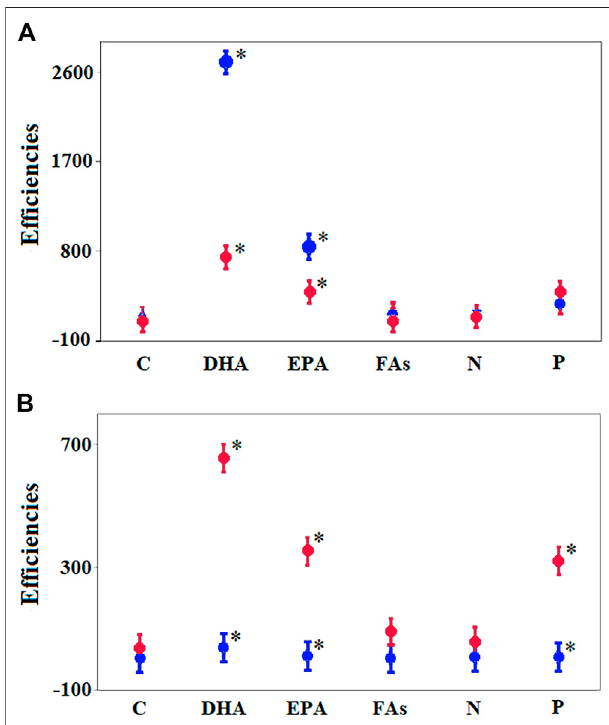
FIGURE 6 | Comparison of the transfer ef fi ciencies of essential substances on day 30 between C-2017 (blue circles) and ZM-2017 (red circles) (A) and between C-2018 (blue circles) and F-2018 (red circles) (B) using two-factor GLM ANOVA (random factor — treatments; fi xed factor — macrobiota). Signi fi cant differences were determined using Fisher ’ s LSD post hoc test (2017: F (cid:2) 41.7, p << 0.001; 2018: F (cid:2) 20.7, p << 0.011). Signi fi cant differences were found for DHA (2017: F (cid:2) 63.6, p (cid:2) 0.001; 2018: F (cid:2) 25.4, p << 0.007), EPA (2017: F (cid:2) 7.1, p (cid:2) 0.05; 2018: F (cid:2) 82.3, p << 0.001), and P (2018: F (cid:2) 10.2; p (cid:2) 0.047) which are designated by